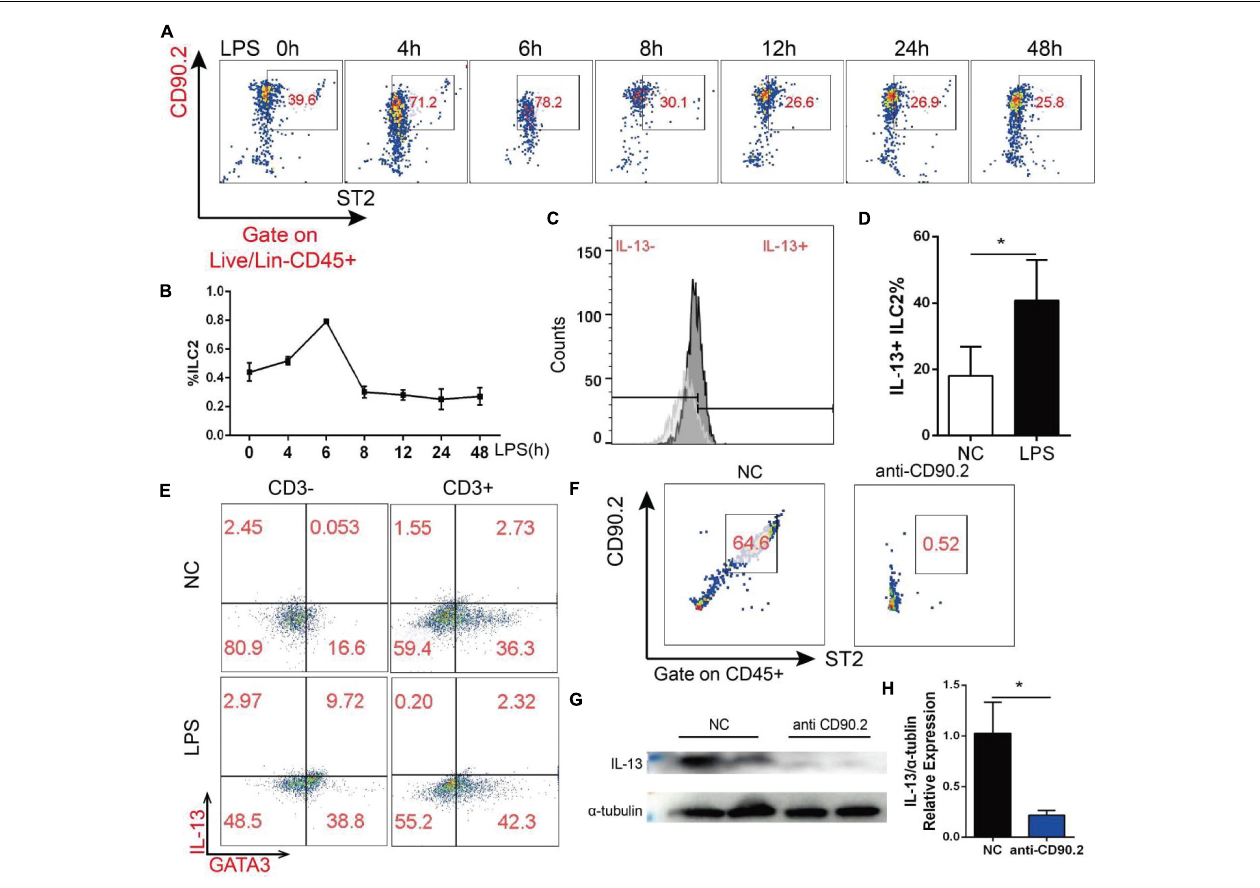
FIGURE 6 | ILC2 change in the myocardial tissue after LPS treatment was correlated with the change of IL-13. (A) Change of ILC2 in the myocardial tissue after LPS treatment. (B) Quantification of (A) . (C) Change of IL-13 positive ILC2 in the myocardial tissue of mice treated with LPS. (D) Quantification of (B) . (E) IL-13 secreted by CD3-negative or CD3-positive T cells; (F) CD90.2 antibody depletion efficiency of ILC2. (G) Expression of IL-13 in the myocardial tissue of mice after CD90.2 antibody treatment. (H) Quantification of (G) . Data were expressed as the mean ± SD ( n = 3). * p <